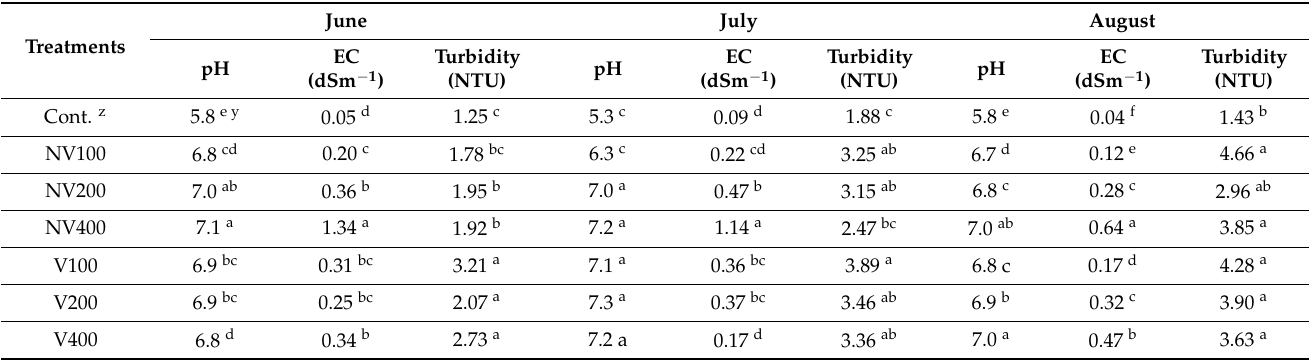
Table 2. pH, EC, and turbidity in runoff from different substrate depths and vegetation plots based on rainfall intensity.